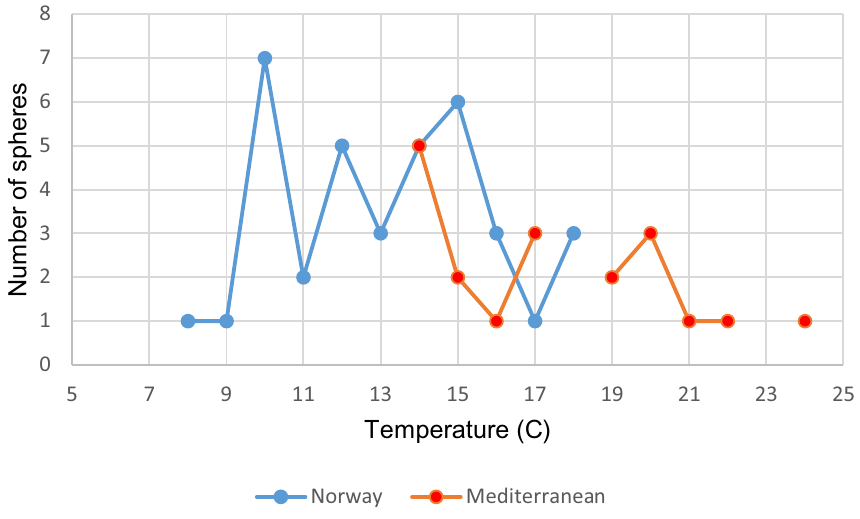
Figure 8. Sphere observations in different water mass temperatures, from NE Atlantic Ocean, including the Mediterranean Sea.